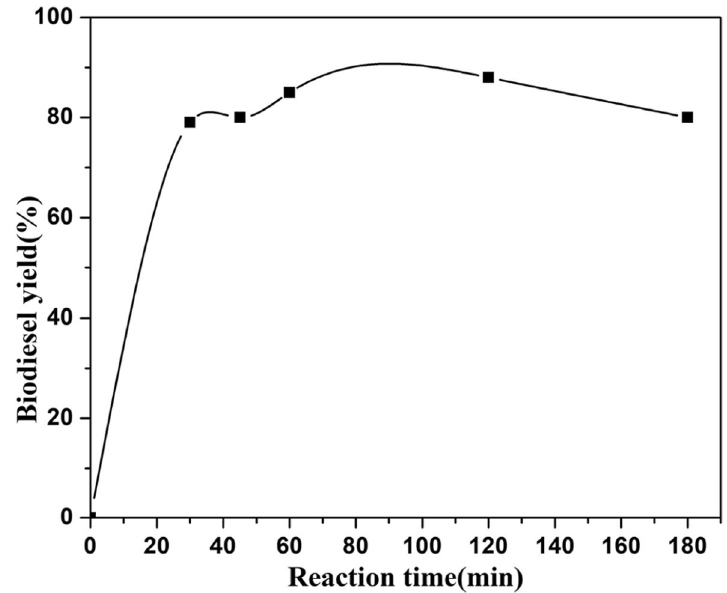
Fig. 10 Effect of reaction duration (min) on biodiesel yield in